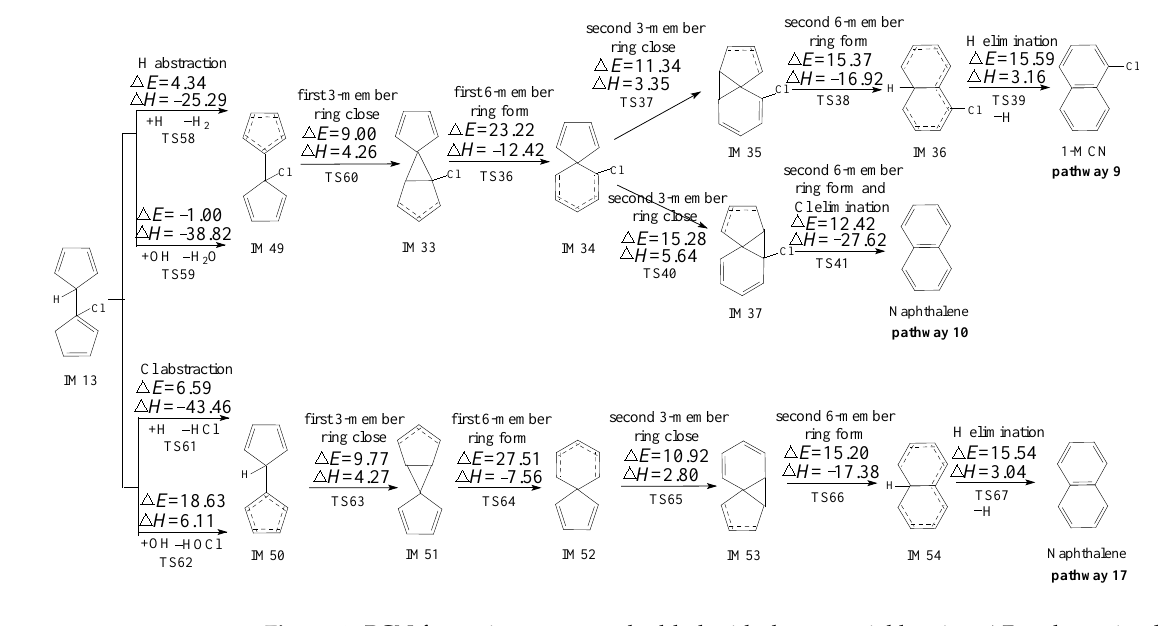
Figure 4. PCN formation routes embedded with the potential barriers Δ E and reaction heats Δ H from IM13.